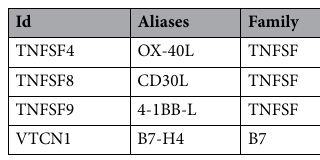
Table 1. Costimulatory molecules.